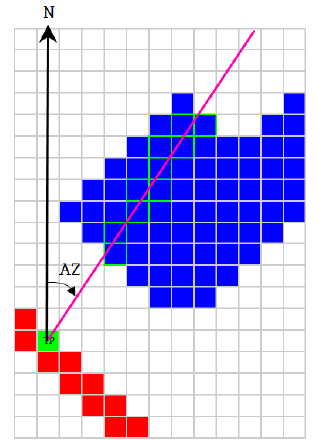
Figure 4. Detailed process of EMP generation algorithm